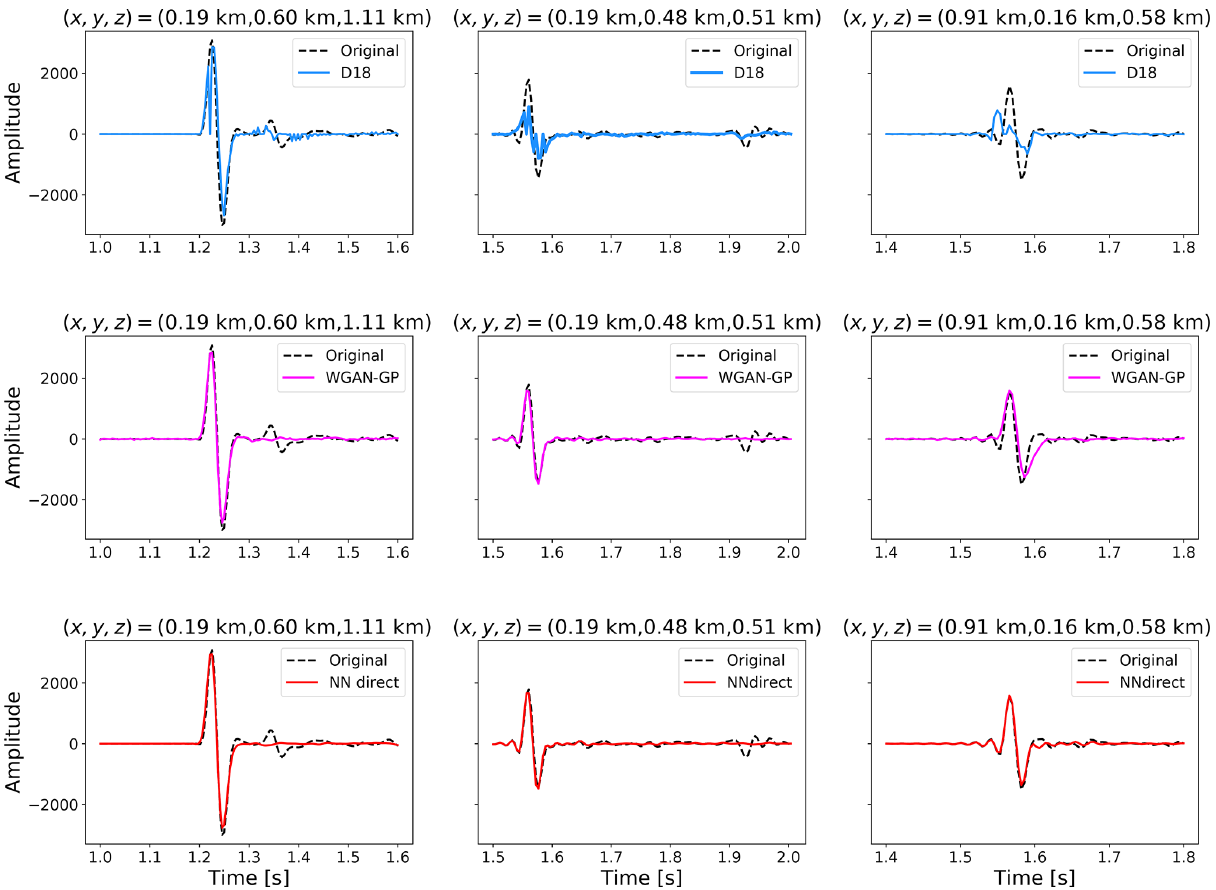
Figure 8. Comparison of the reconstruction accuracy of different emulation methods on three random seismograms from the testing set (dashed black lines), whose coordinates are reported on top of each panel. The seismograms record the vertical component of motion at the receiver placed on the point with coordinates (0.5km, 0.5km, 2.43km). The horizontal axis is zoomed around the location of the P-wave peak. In addition to the D18 method (in blue), we show the performance of the methods achieving lowest and highest accuracy as reported in Table 1: the WGAN-GP model (pink) and the NN direct model (red), respectively.